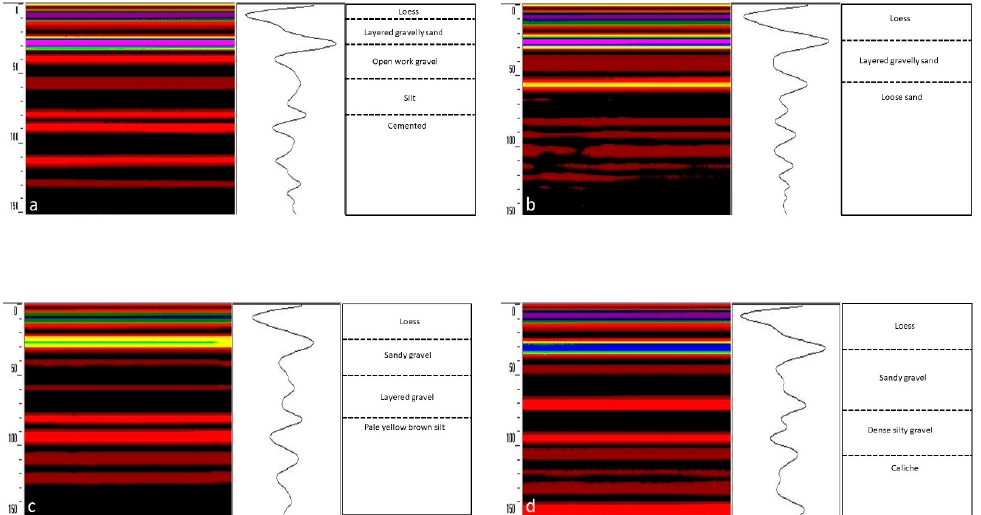
Figure 5. Determination of the dielectric permittivity of sediments along the GPR transects. GPR